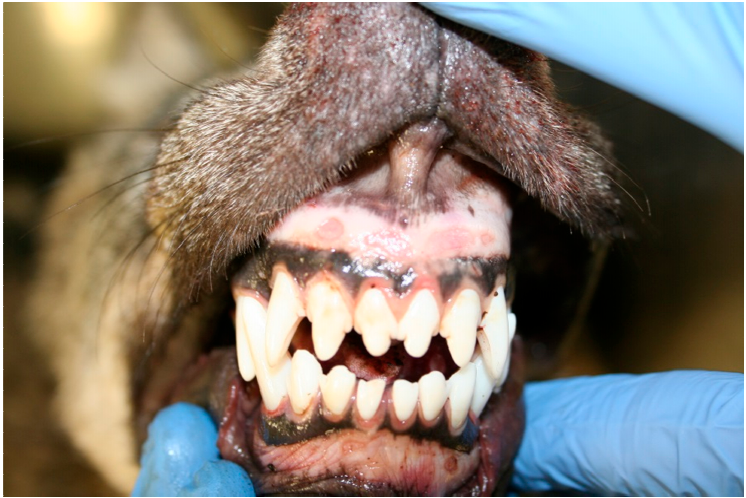
Figure 1. Erosive lesions in the upper and lower gingival.